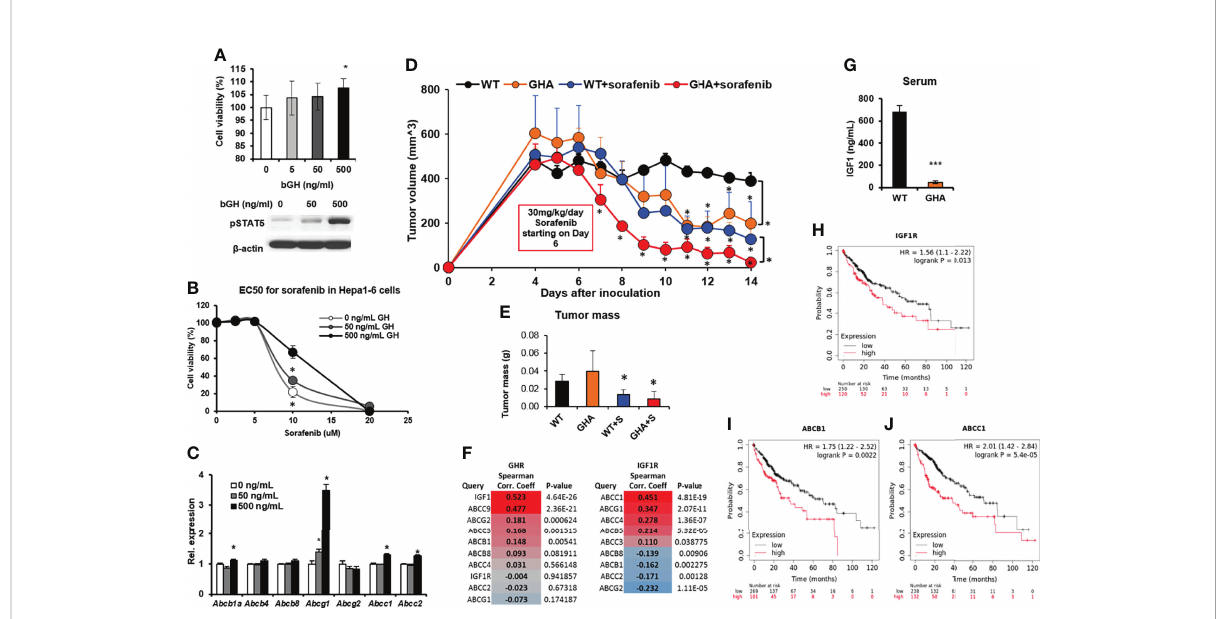
FIGURE 5 Effect of GHRA on response of syngeneic mouse hepatocellular carcinoma tumors to sorafenib treatment in vivo. (A) Mouse Hepa1-6 hepatocellular carcinoma (HCC) cells respond to bovine GH stimulation in culture showing increased cell viability and STAT5 activation after 72 hours (A) as well as increase in the EC50 dose of sorafenib (B) . Additionally, GH treatment increased ABC transporter levels in the cultured Hepa1-6 cells (C) . Mouse Hepa1-6 cells grafted subcutaneously on the right fl ank of syngeneic C57BL6/J wild-type (WT) and GHA mice (transgenic for bGH G119K GHR antagonist) (n=6). The changes in tumor volume (Hepa1-6 in WT and GHA mice) from digital caliper measurement (D) and post-dissection tumor mass (E) show suppressed tumor growth and improved tumoral response to sorafenib in the GHA mice. (F) Spearman correlation analysis for transcript levels of GHR and ABC transporter and IGF1R and ABC transporters in the tumor of 371 HCC patients in the TCGA cohort. (G) Serum IGF1 levels of Hepa1-6 tumor-bearing GHA mice are signi fi cantly lower than that of tumor-bearing WT mice. (H – J) Correlation of overall survival probability of 371 HCC patients in the TCGA cohort with RNA expression of IGF1R (H) , or ABCB1 (I) , or ABCC1 (J) . (*p < 0.05, ***p < 0.001, mouse studies – repeated measure using SPSS; other assays - Students t test, n =